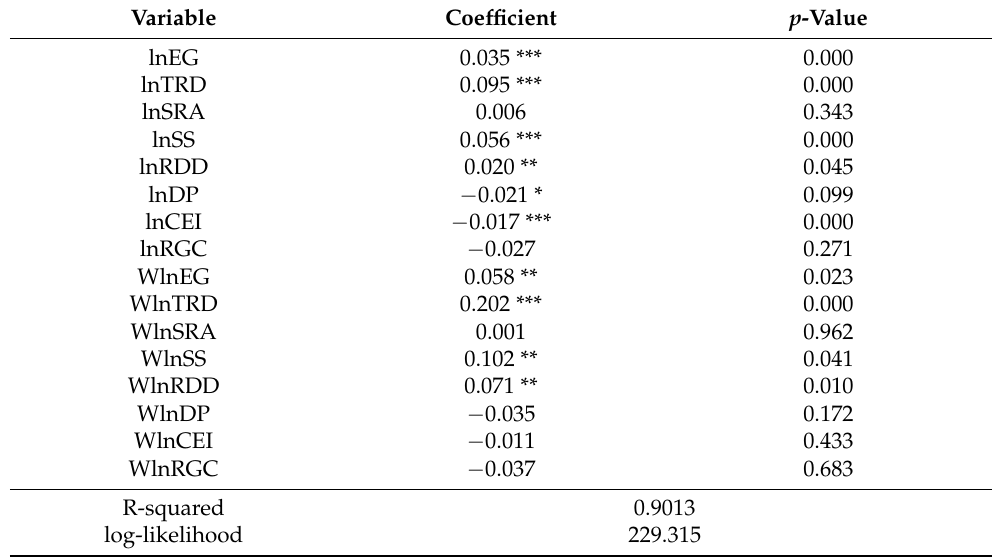
Table 5. Regression results of the spatial Dubin model.